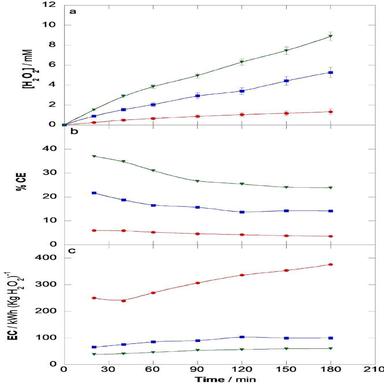
Influence of different cathodes on (a) accumulated H2O2 concentration vs time (b) current efficiency and (c) energy consumed per kg H2O2 using 150 mL of 50 mM Na2SO4 solution at pH 2.5 and 25 C, using ( ) PW03, ( ) PCL6/PW03 and ( ) Pd1%/ PCL6/PW03/gas diffusion.